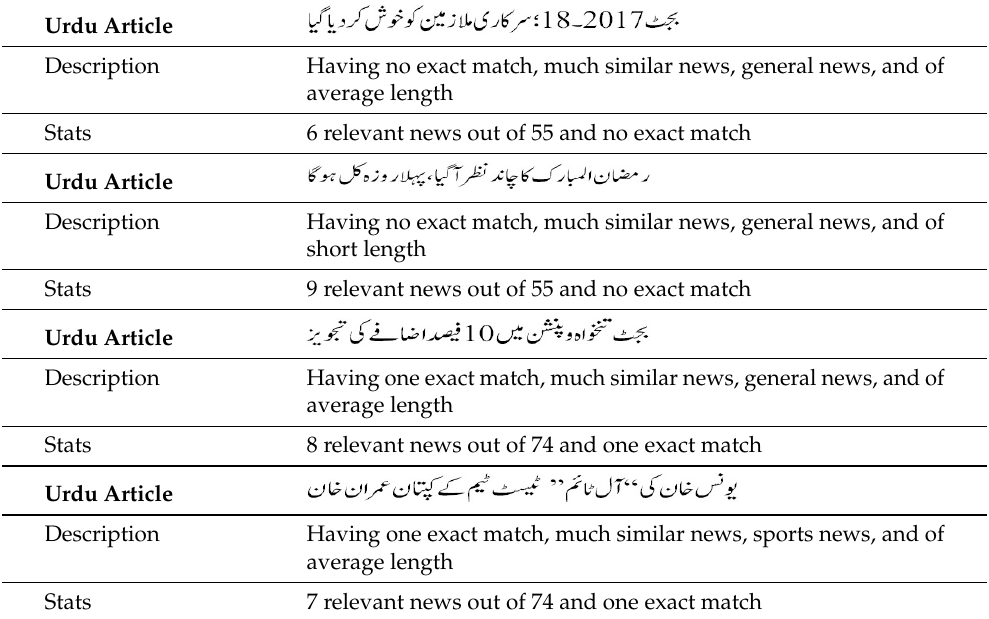
Table 5. News articles to be analyzed for